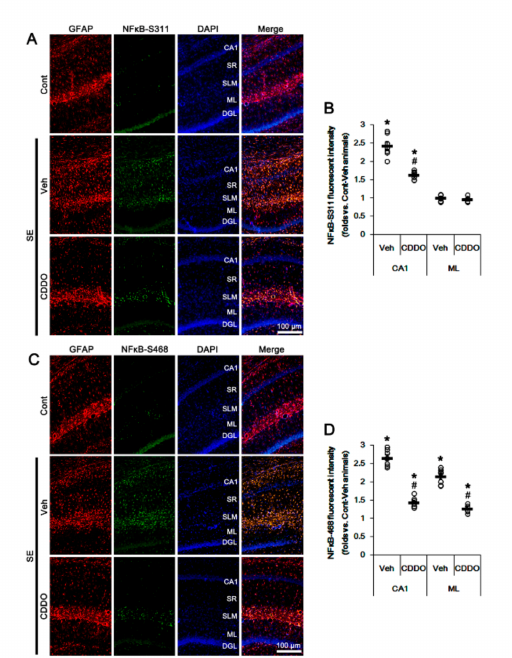
Figure 5. E ff ects of CDDO-Me on NF κ B phosphorylation following SE. NF κ B-S311 and -S468 phosphorylations are increased in reactive CA1 astrocytes, but only-S468 phosphorylation is elevated in ML astrocytes, which were abrogated by CDDO-Me. ( A ) Representative photos of NF κ B-S311 phosphorylation in the hippocampus. Abbreviations: CA1, CA1 pyramidal cell layer; SR, stratum radiatum; SLM, stratum lacunosum-moleculare; ML, molecular layer of the dentate gyrus; DGL, dentate granule cell layer. ( B ) Quantification of the fluorescent intensity of NF κ B-S311 phosphorylation in CA1 and molecular layer regions. Open circles indicate each individual value. Horizontal bars indicate mean value. Vertical bars indicate S.E.M. (*,# p < 0.05 vs. control animals and vehicle, respectively, one-way ANOVA followed by Newman-Keuls post hoc test; n = 7, respectively). ( C ) Representative photos of NF κ B-S468 phosphorylation in the hippocampus. ( D ) Quantification of the fluorescent intensity of NF κ B-S468 phosphorylation in CA1 and molecular layer regions. Open circles indicate each individual value. Horizontal bars indicate mean value. Vertical bars indicate S.E.M. (*,# p < 0.05 vs. control animals and vehicle, respectively, one-way ANOVA followed by Newman-Keuls post hoc test; n = 7,